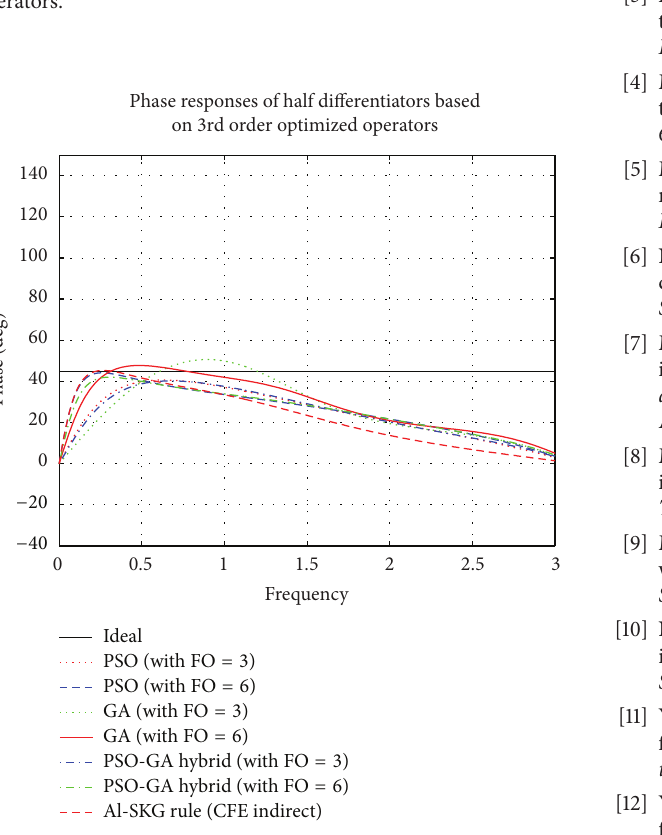
Figure 10: Comparison of relative magnitude errors (dB) of pro- posed half differentiators based on 3rd order optimized differential operators.